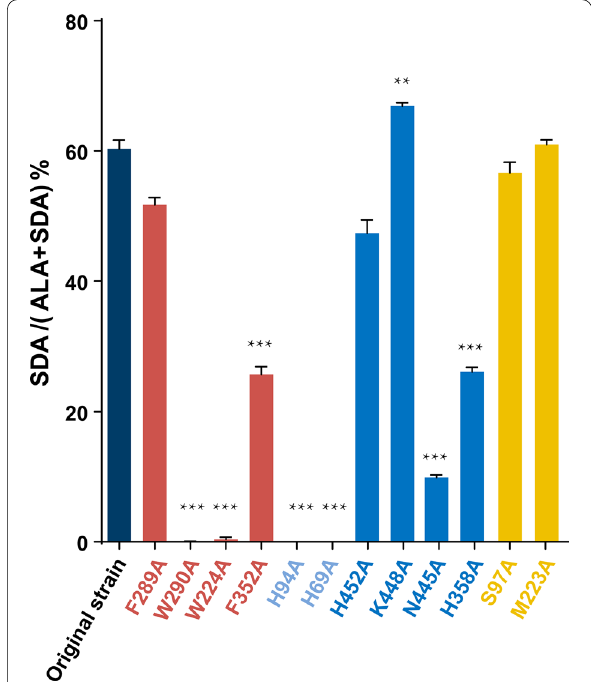
Fig. 3 Activities of wild-type Mp FADS6 and mutants to ALA. The sites predicted to constitute the substrate channel of Mp FADS6 are indicated in red. The sites of Mp FADS6 predicted to bind heme are indicated in light blue. The sites of Mp FADS6 predicted to recognize and bind the head group of ALA-CoA is indicated in blue. Mutant obtained by accident is indicated in yellow. * p < 0.05. ** p < 0.01. *** p < 0.001